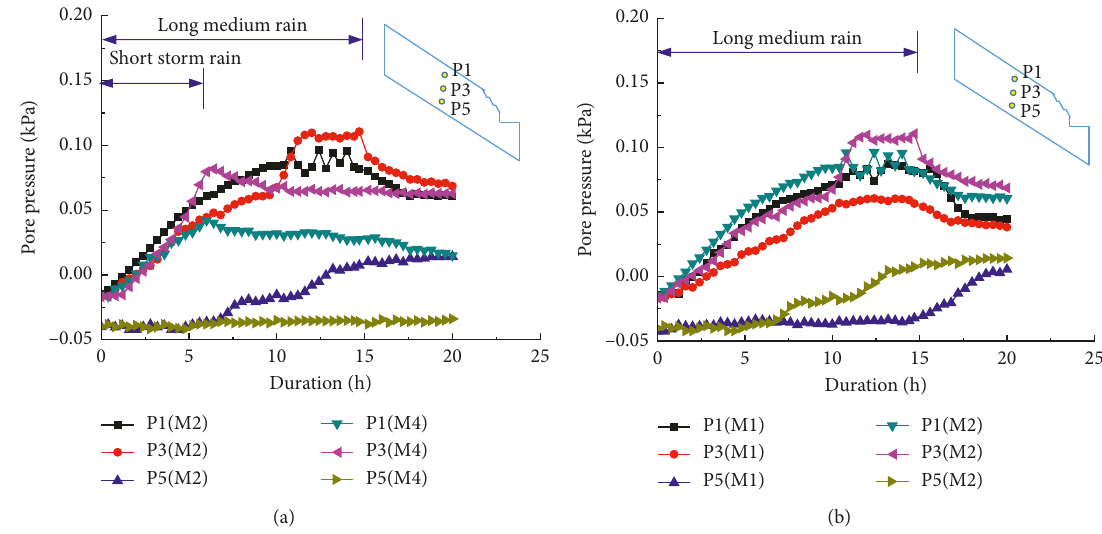
Figure 7: Comparison of pore pressure along the depth direction: (a) slope inclined at 50 ° under different rainfall conditions; (b) slope inclined differently under the same long-term medium